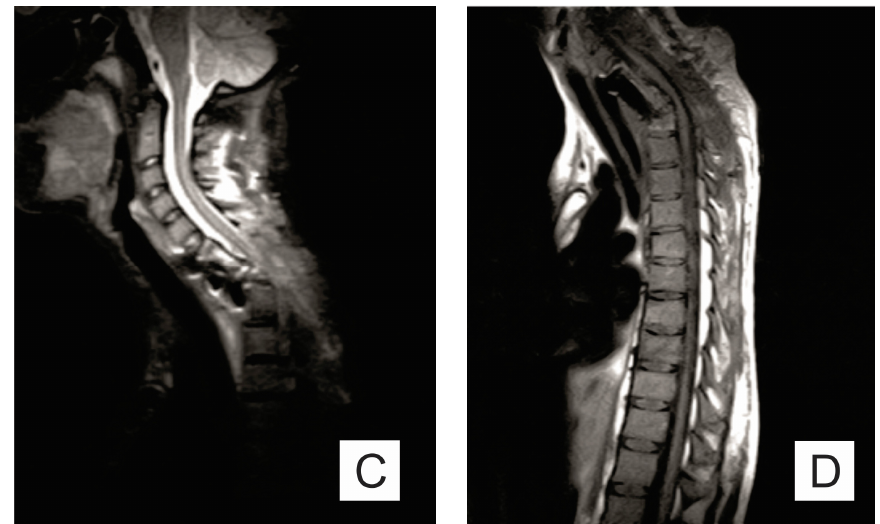
Figure 1. ( A ) Sagittal CT scan: osteolytic lesions (C6–C7, T1–T2), pathological fracture of the C7 vertebra; ( B ) sagittal T2 MRI; ( C ) sagittal STIR MRI; and ( D ) sagittal T1 MRI: important spinal canal stenosis at C6–C7 level up to an anteroposterior diameter of 5 mm, the medullary cord presents in this area discreetly T2-STIR hypersignal.